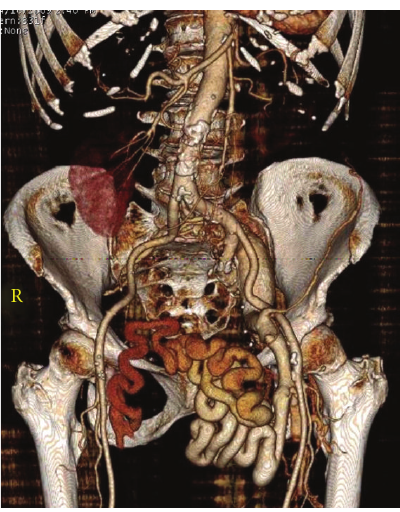
Figure 4: 3D reconstruction of the left pelvic AVM with outflow to the left external iliac vein and collateral veins leading to the right common femoral vein (not shown). The supplying arteries are the left internal iliac a. (arrow) and the left 5th lumbar a. (arrowhead).